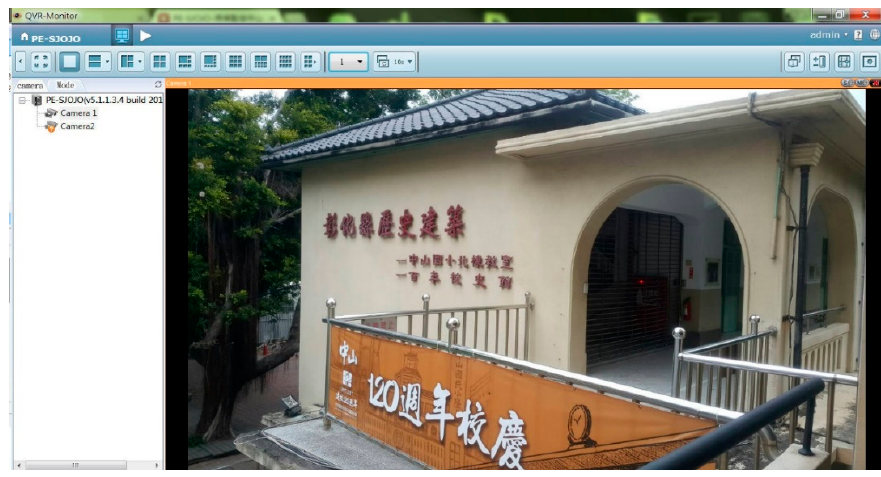
Figure 8. Backup interface of the surveillance and management system on a personal computer.